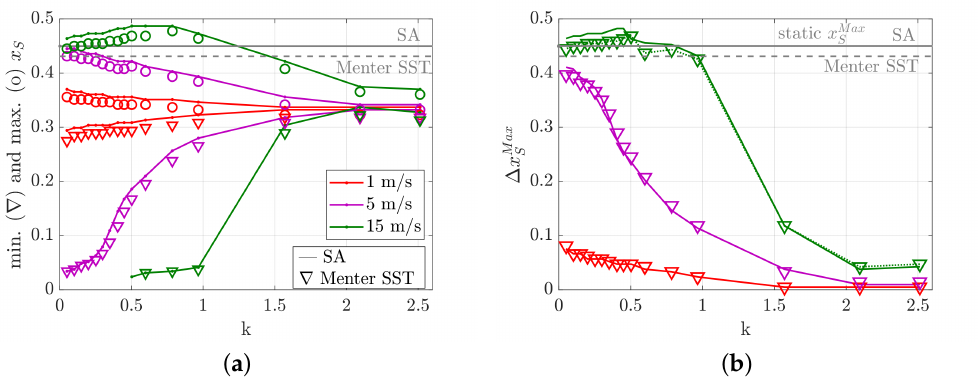
Figure 17. Shock motion in comparison between Spalart-Allmaras (solid lines) and Menter SST (sym- bols) at Mach 0.70, ( a ) Minimum and maximum x-coordinates for the shock position, ( b ) Maximum shock motion during one period of